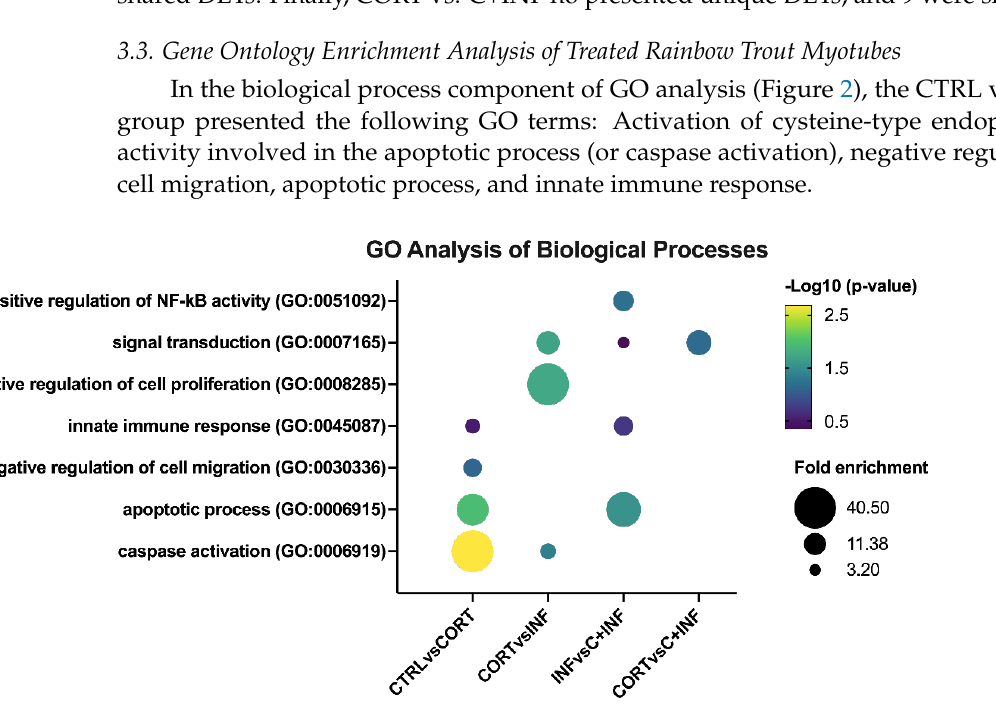
Figure 2. GO analysis of biological processes in rainbow trout myotubes treated with cortisol and/or infected with P. salmonis . The most representative and significant biological processes are represented in bubble plots and are sorted by group. The dot size indicates the fold enrichment associated with the process, and the dot color indicates the significance of the enrichment (−log10(the modified Fisher exact p -value)). Abbreviations: CTRL, control; CORT, cortisol; INF, infec- tion; C+INF, cortisol+infection.